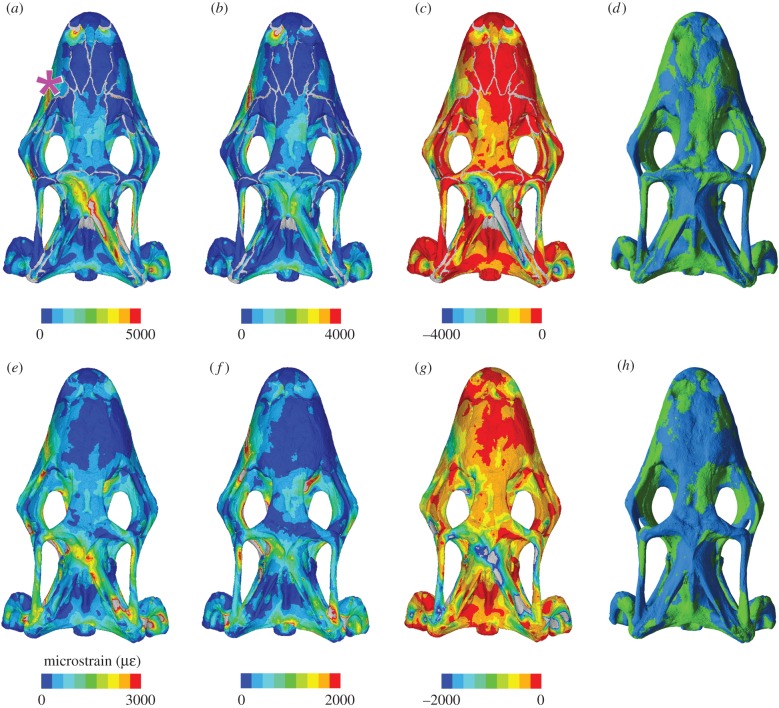
Strain contour plots and tension–compression dominance plots of the cranium under posterior loading in dorsal view with a chondrocranium of 200 MPa and sutures present (a–d) and absent (e–h) showing: von Mises strain (a,e), 1st principal strains (b,f), 3rd principal strains (c,g) and plots of whether strains are dominated by tension (green) or compression (blue). The pink asterisk indicates the location along the tooth row at which loading was applied (a–h). In the contour plots, strain values are given in microstrain and the sutures are shown in grey (a–c and e–g).